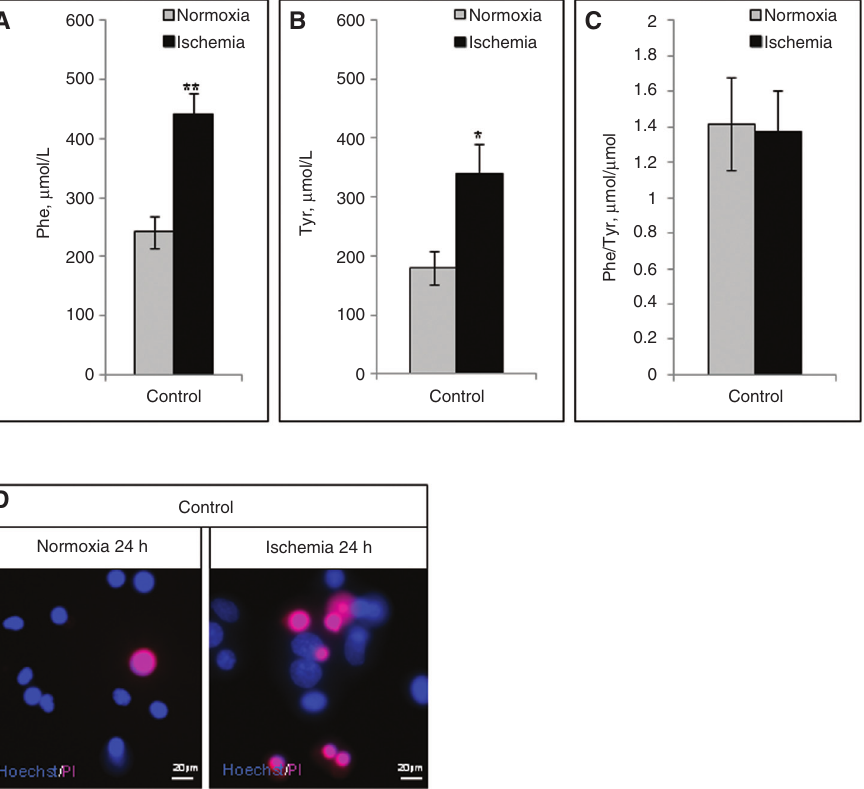
Figure 1 Phenylalanine and tyrosine concentrations in normoxic and ischemic PC12 cell cultures. Neuronal PC12 cells were